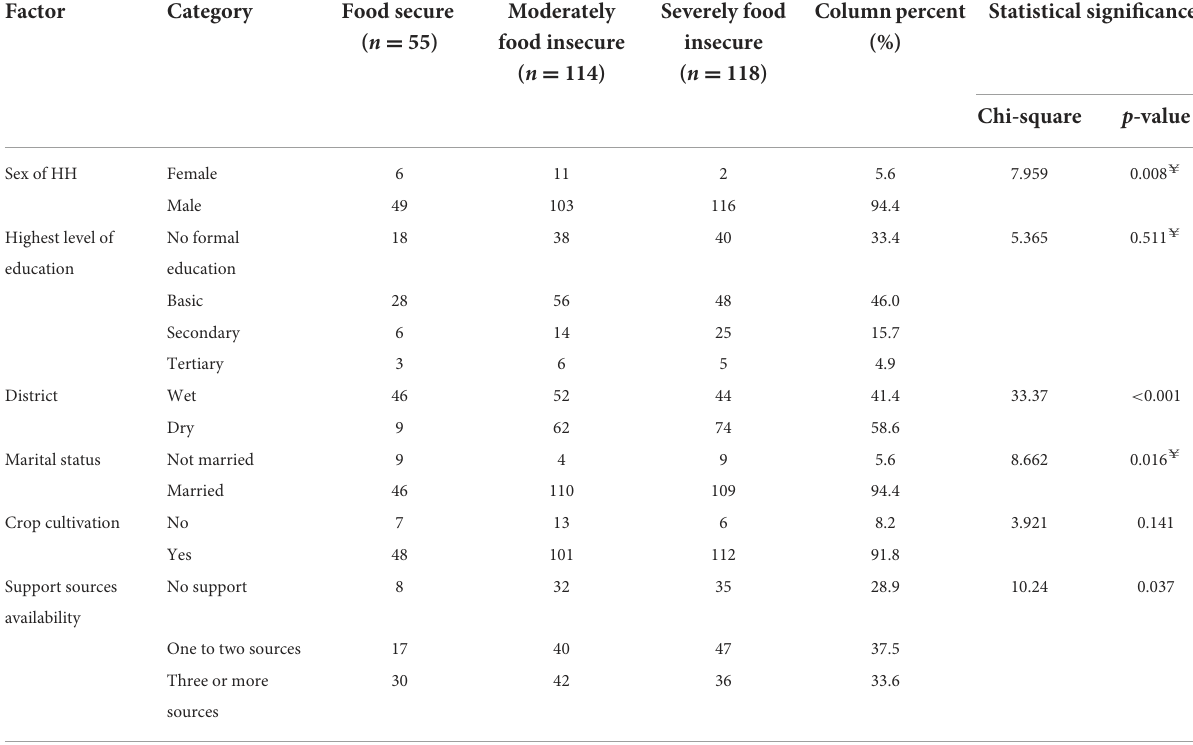
TABLE 2 Factors influencing the food security level of cattle farming households in Ghana (Part